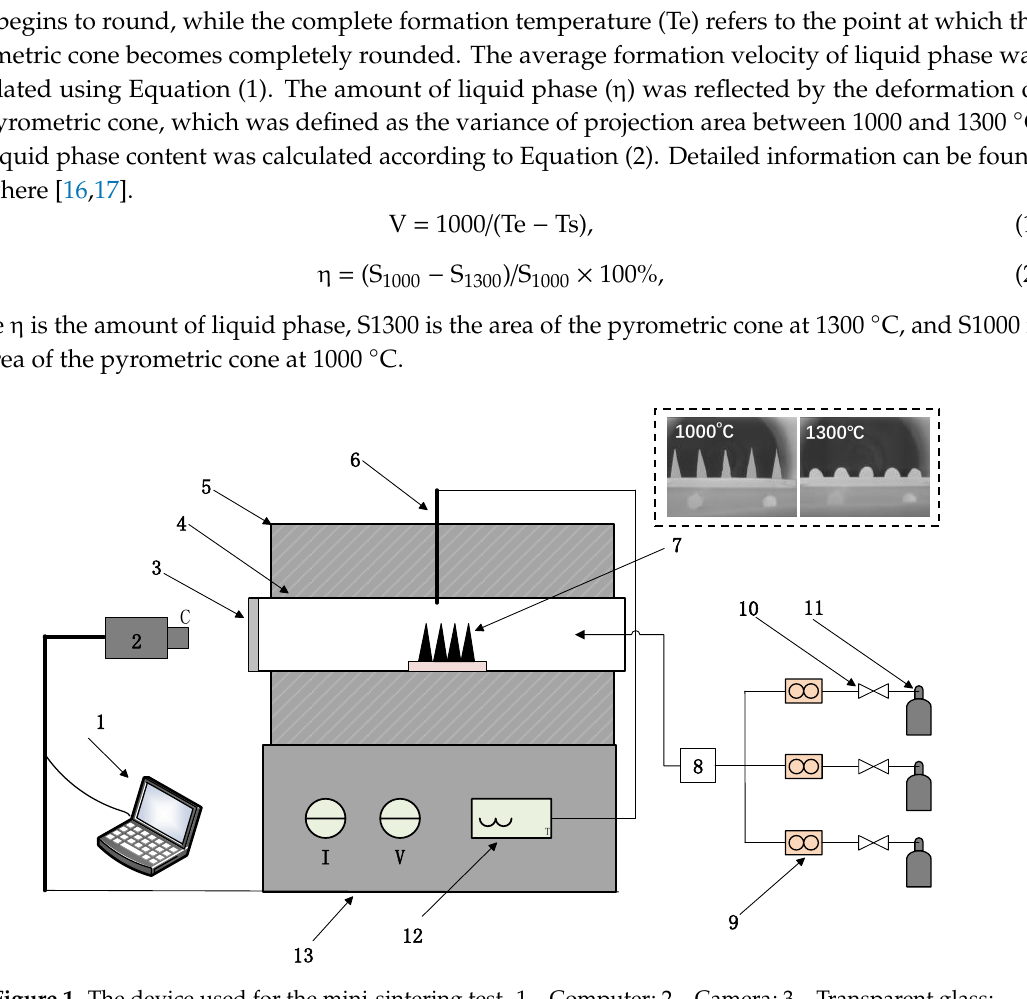
Figure 1. The device used for the mini-sintering test. 1—Computer; 2—Camera; 3—Transparent glass; 4—Silicon tube; 5—Heating furnace; 6—Thermocouple; 7—Standard pyrometric cone; 8—Gas mixer; 9—Flowmeter; 10—Reducing valve; 11—Gas bottle; 12—Temperature display panel; 13—Controller.